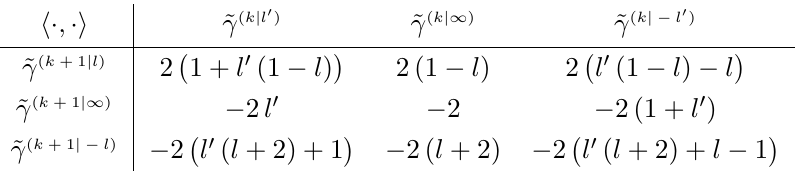
1 , and the third column, where l 0 ≥